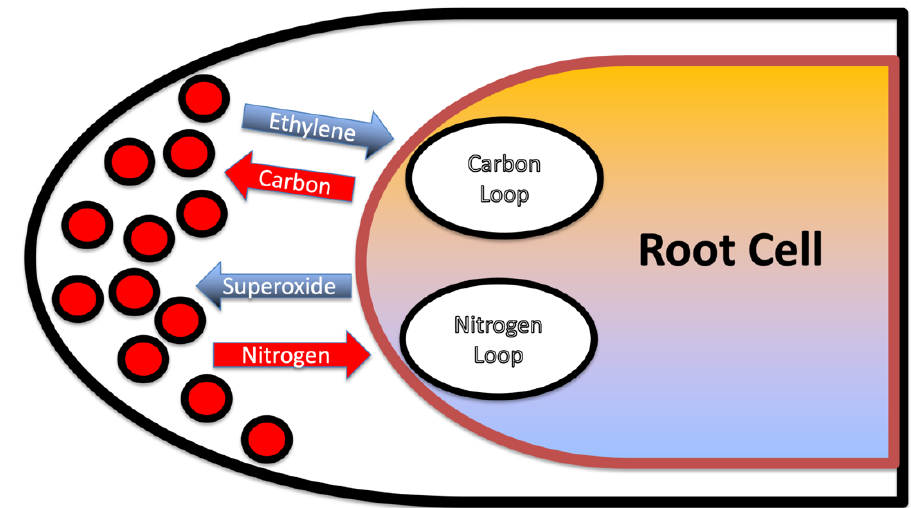
Figure 17. Diagrammatic representation of the nutritional loops (exchanges) that the microbes are engaged in within root cells. The carbon loop involves secretion of ethylene by microbes with a release of carbohydrate by the root cell to the microbes. The nitrogen loop involves production of superoxide by the root cell that then causes microbes to secrete nitrogen in the form of nitric oxide which is converted to nitrate and absorbed by the root cell.